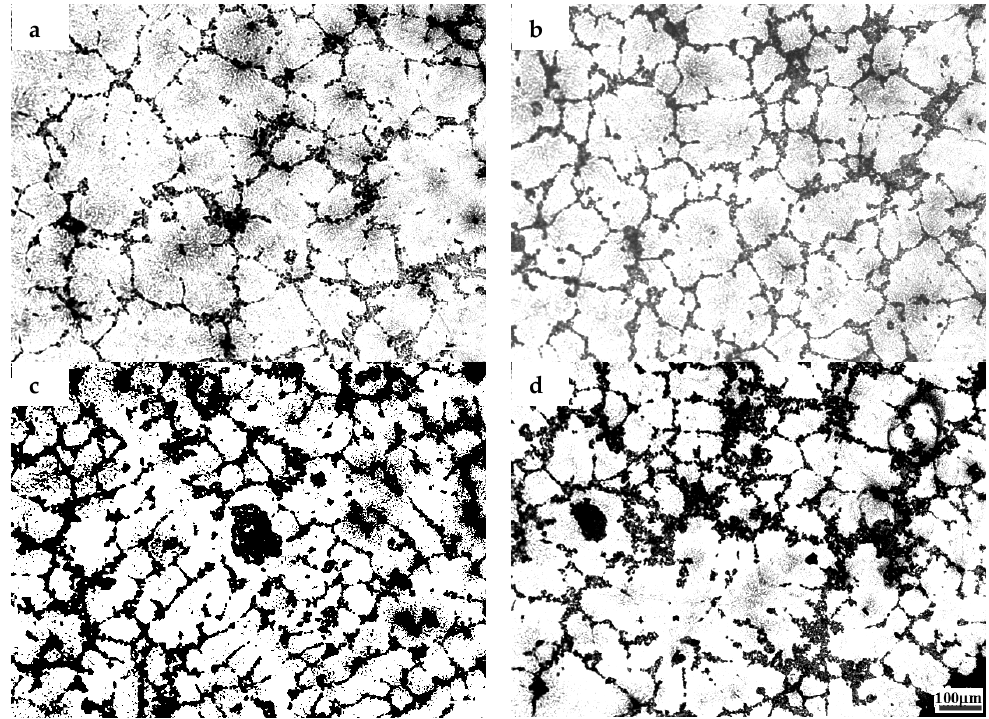
Figure 2. The microstructures of TiB 2 /7075 Al matrix composites with cooling rate of 20 °C/min. ( a ) 3.0% TiB 2 /7075; ( b ) 4.5% TiB 2 /7075; ( c ) 6.0% TiB 2 /7075; ( d ) 9.0% TiB 2 /7075.